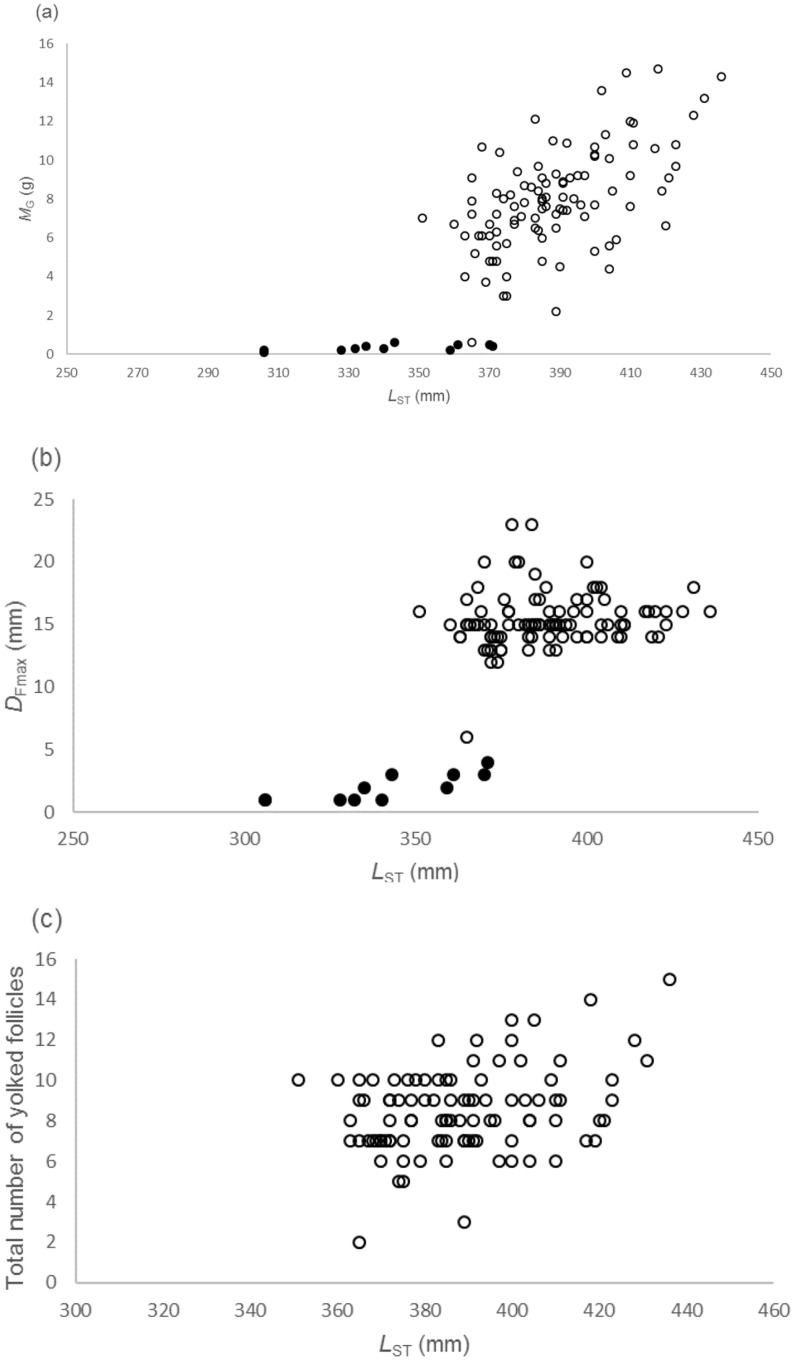
The relationship between stretched total length (LST) and reproductive indices of Asymbolus pallidus females.(a) LST and total ovary weight (MG), (b) LST and maximum follicle diameter (DFmax) and (c) LST and number of yolked follicles. Immature (closed circle) and mature (open circle).